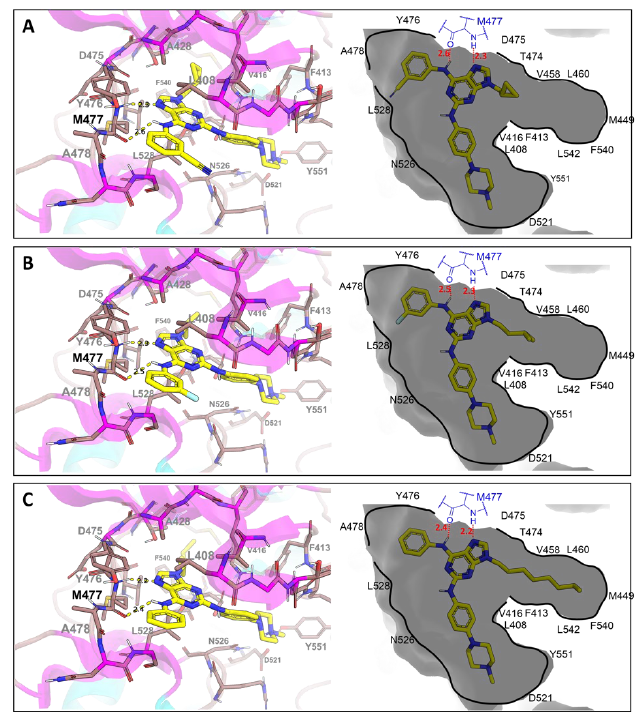
Figure 9. Representations of the binding modes of compounds 4f ( A ), 5b ( B ) and 5j ( C ) at the BTK active site. The image on the right is the three-dimensional representation of the best docking result for each compound. The image on the left is a top view of a diagram of ligand interactions with the binding site.